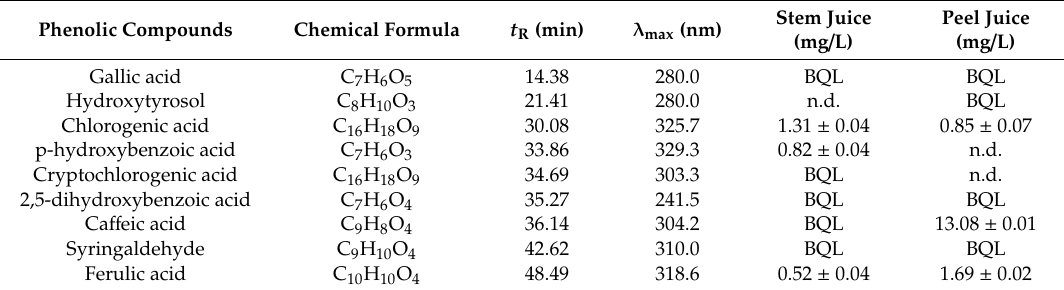
Table 5. Identification and quantification of phenolic compounds present in pineapple by-products by HPLC analysis. Evaluation of stem and peel liquid